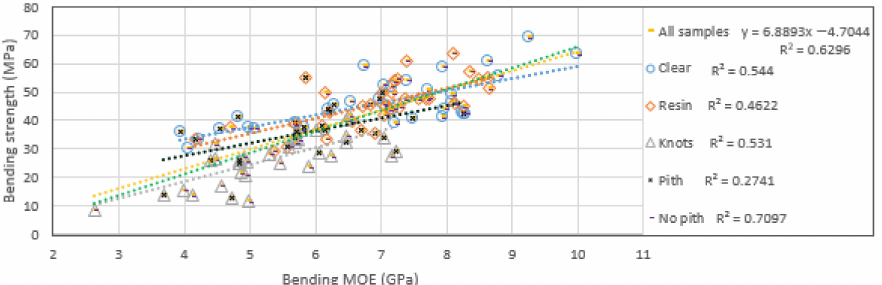
Figure 12. Relationship of bending MOE and strength.